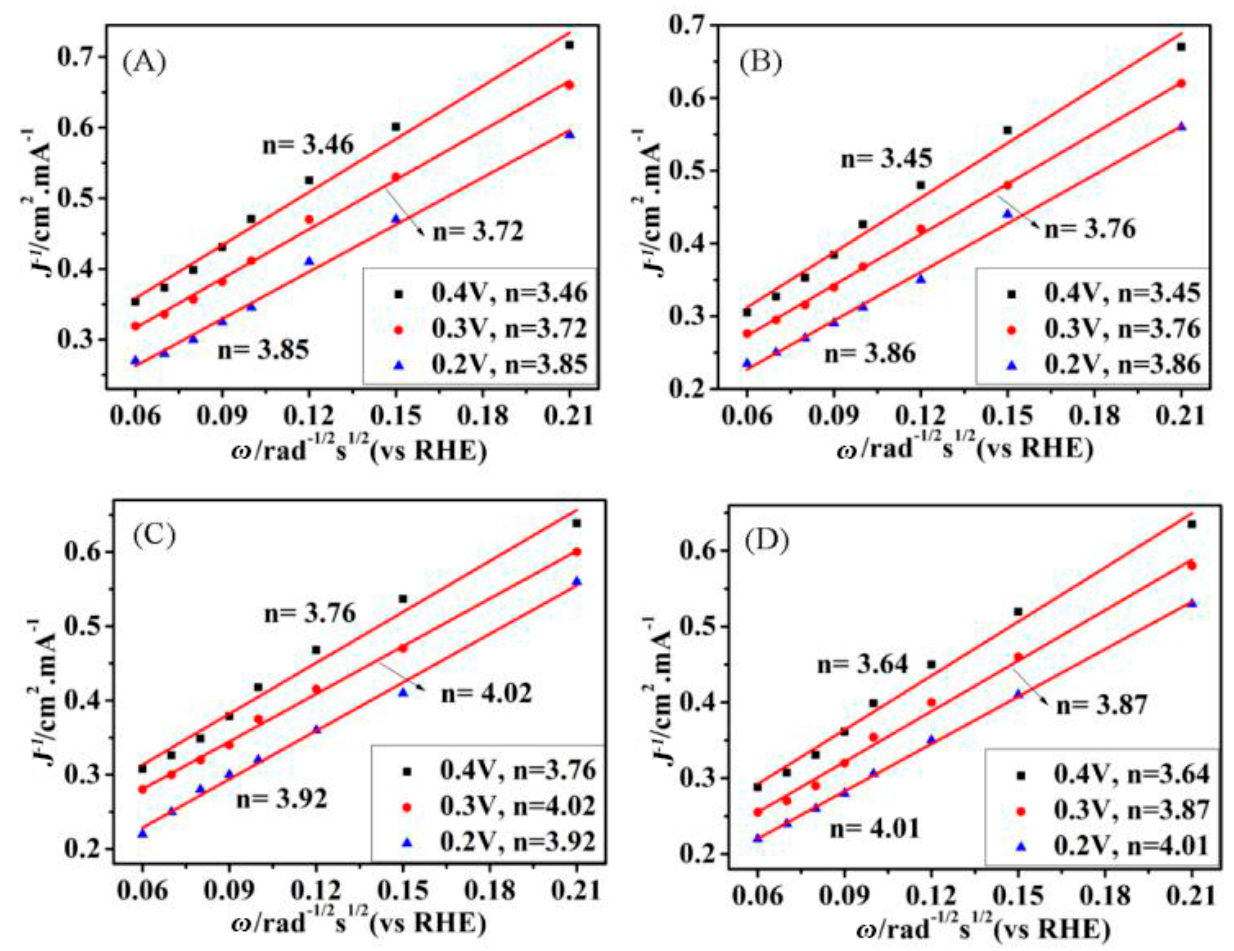
Figure 6. Koutecky-Levich plots for the MoS 2 /C-15 ( A ), MoS 2 /C-20 ( B ), MoS 2 /C-25 ( C ), and MoS 2 /C-30 ( D ) at different electrode potentials.